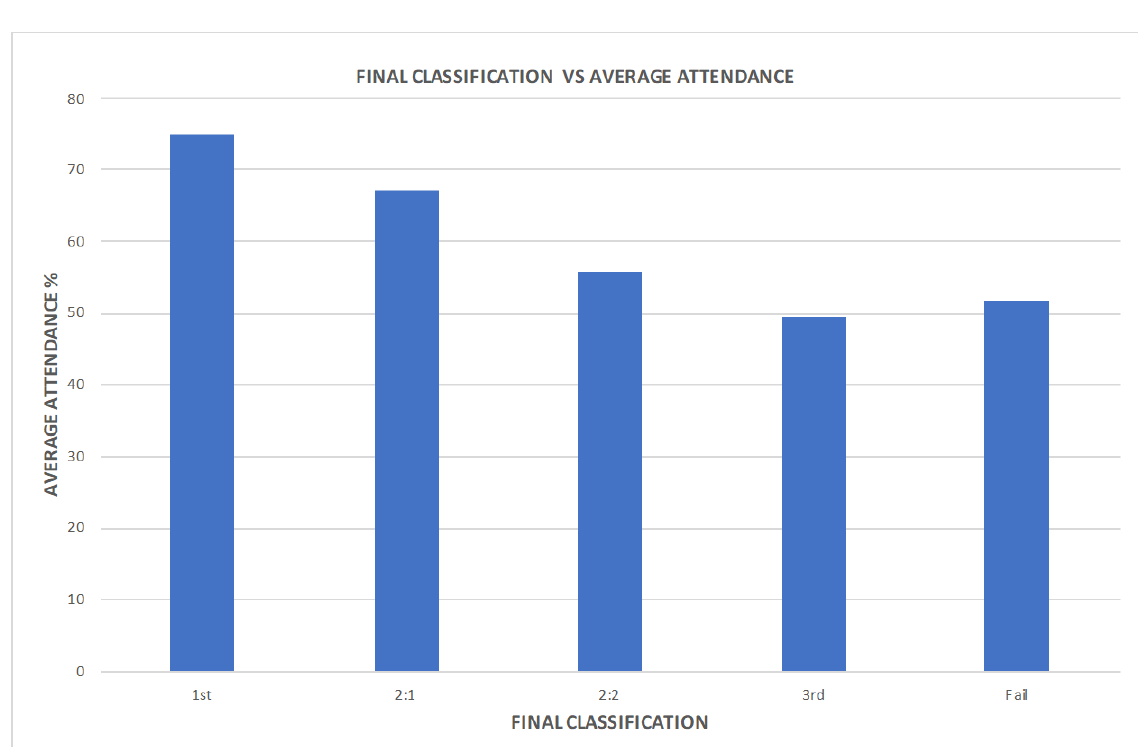
Figure 3 . Final Classification vs Average